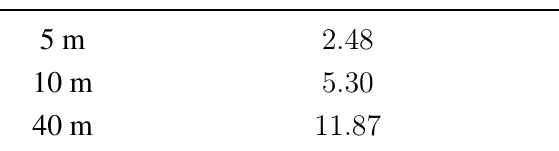
Table 1. Average number of candidates for mCHT-based detection.